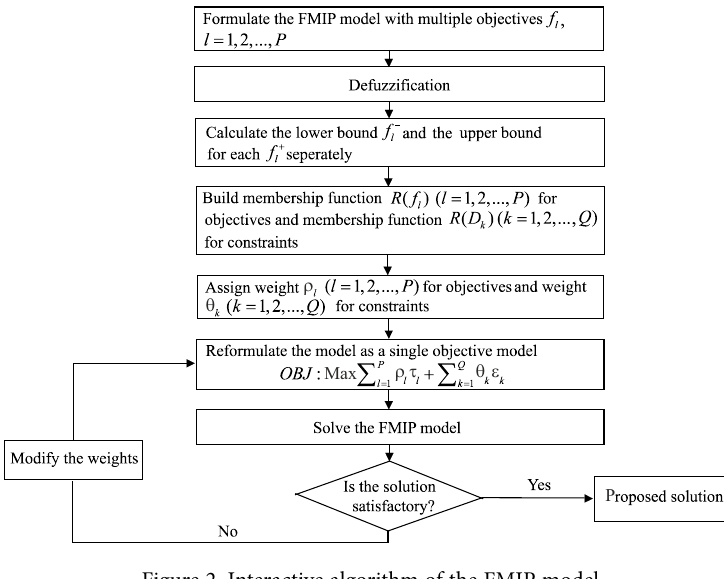
Figure 2. Interactive algorithm of the FMIP